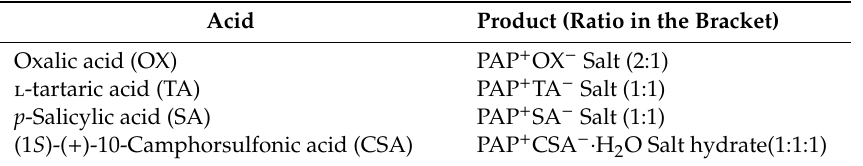
Table 2. List of salts and their